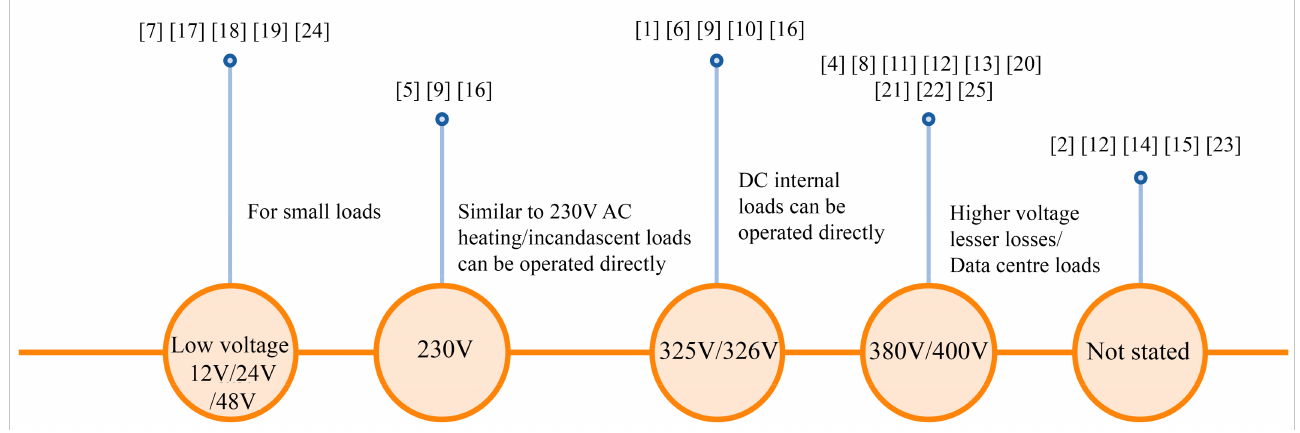
Figure 5. Consideration of voltage levels by various authors